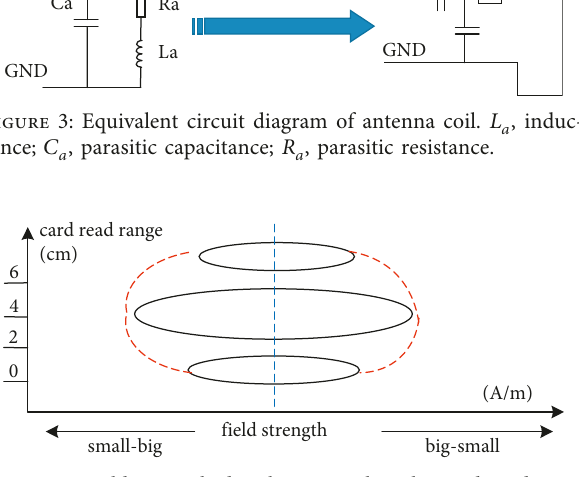
Figure 4: Field strength distribution within the card read-write